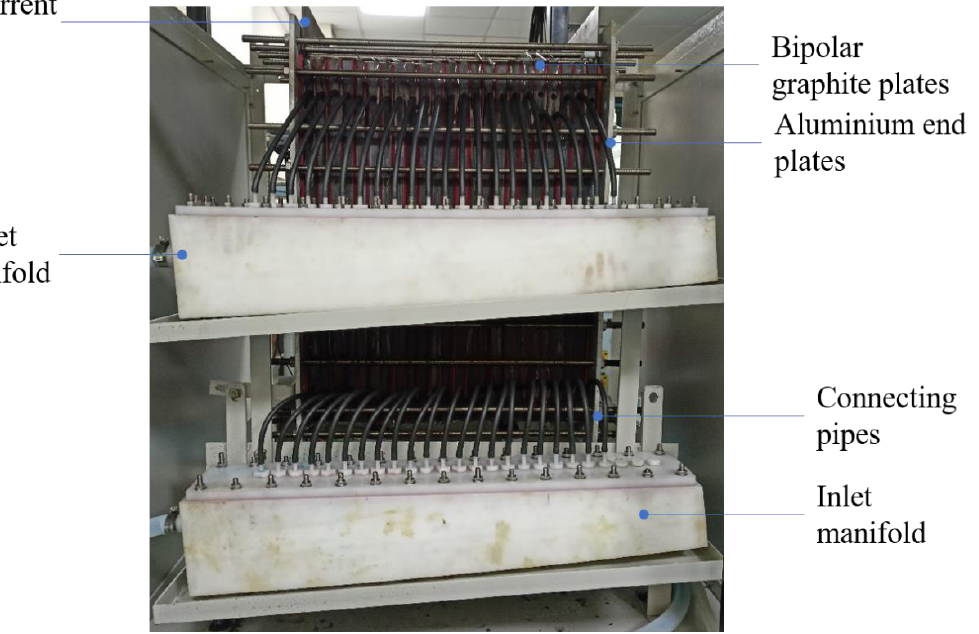
Figure 1. The 22-cell VRFB stack with the nominal power of 5 kW and a nominal electrode surface area of 1500 cm 2 that was used for constant power characterization studies.